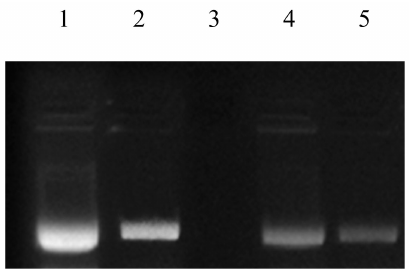
Figure 5. DNA damage protection activities in rye extracts against Fenton’s reagent. Lane 1: native pBR 322 plasmid DNA; Lane 2: DNA + Fenton’s reagent + Quercetin (mg/mL positive control); Lane 3: DNA + Fenton’s reagent; Lane 4: DNA + Fenton’s reagent + WRE (Black); Lane 5: DNA + Fenton’s reagent + WRE (White).